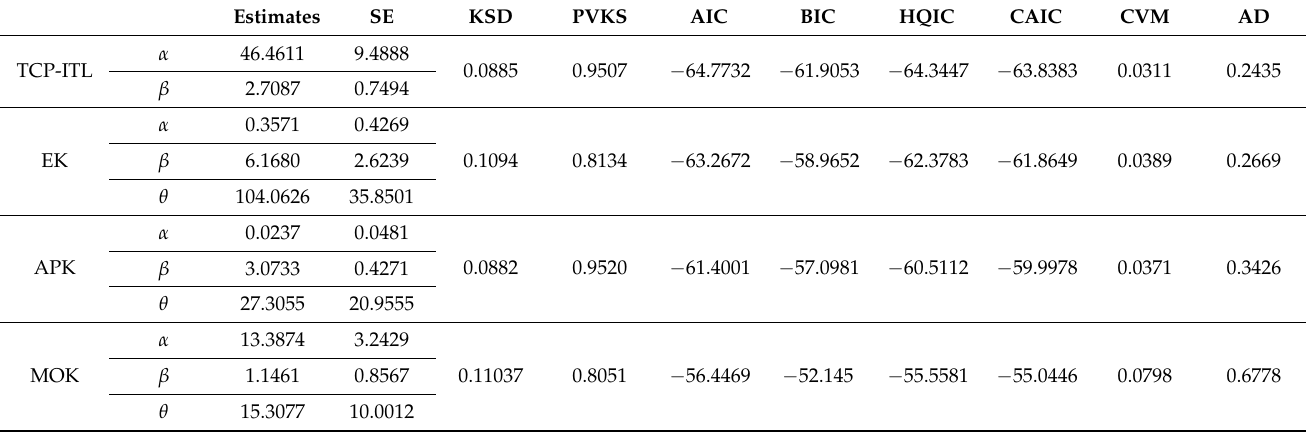
Table 10. MLE and different measures for each model of Senegal COVID-19 data